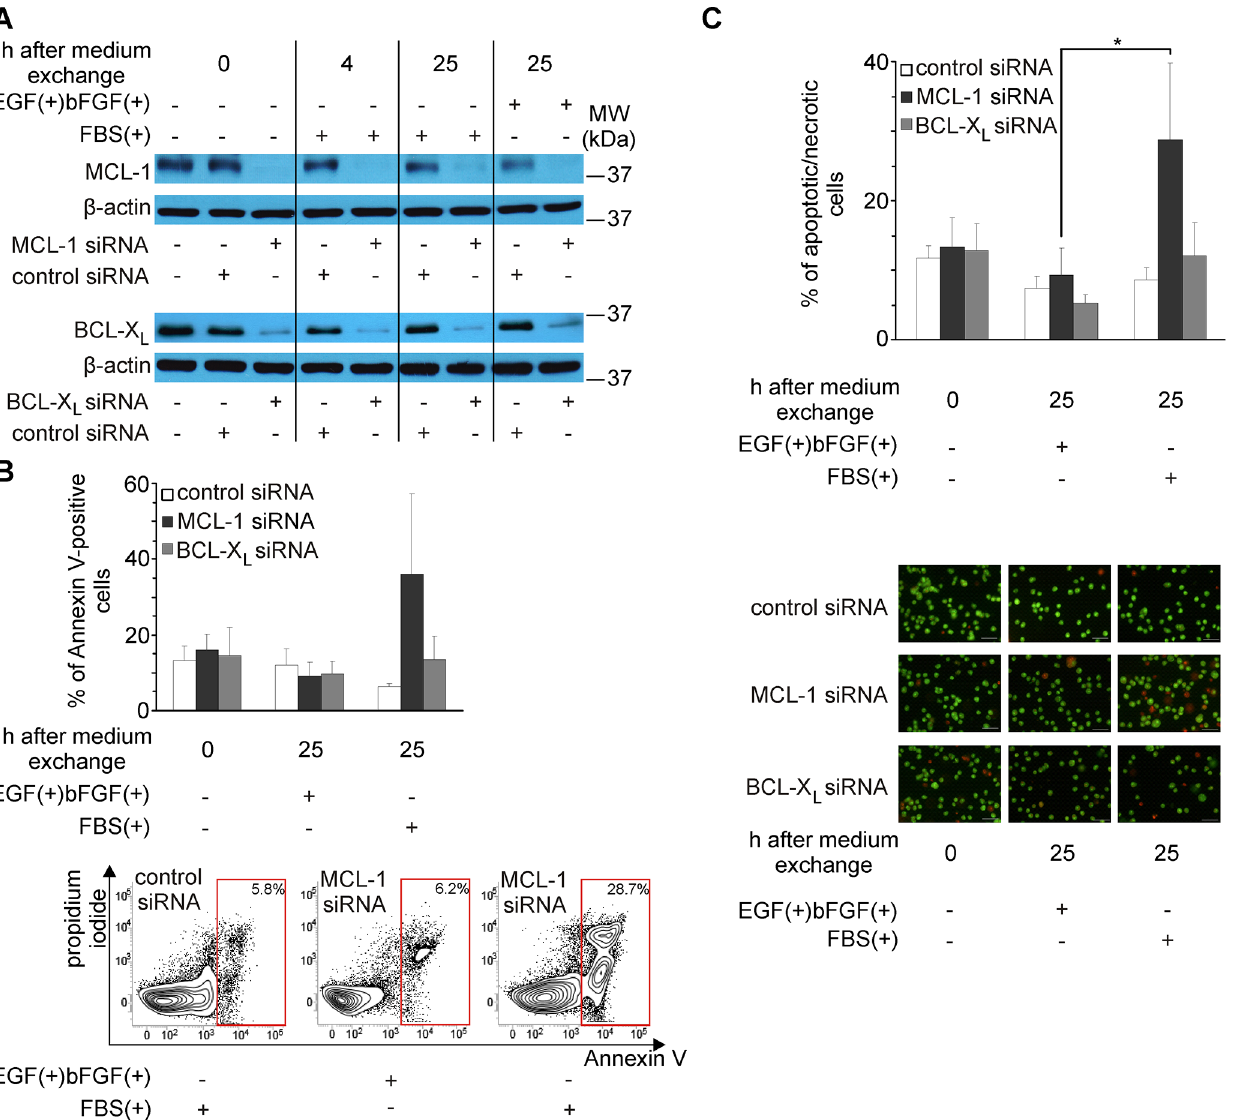
Fig 4. MCL-1 is involved in melanoma cell survival during adaptation to serum-containing medium. DMBC12 cells with silenced expression of MCL-1 or BCL-X L (0h) were exposed to serum-containing medium (FBS(+)), or in parallel they were transferred to fresh EGF(+)bFGF(+) medium. (A) Cell lysates were prepared at indicated time points and MCL-1 and BCL-X L proteins were immunoblotted (n = 3). Localization and molecular weight (MW) of marker bands are indicated. β -actin was used as a loading control. (B) Cells were stained with Annexin V/propidium iodide (PI) before (0h) and 25 h after medium exchange, and analyzed by flow cytometry. The percentage of Annexin V-positive cells is shown. Representative counter plots for melanoma cells after transfection with either control or MCL-1 siRNA are shown. They were acquired 25 h after transfected cell were transferred to either fresh EGF(+)bFGF(+) medium or serum-containing medium (FBS(+)). Data are presented as the means ± SD from three independent experiments. (C) Quantitative analysis of the frequency of melanoma cells stained with acridine orange/ethidium bromide before (0 h) and 25 h after medium exchange. The percentage of apoptotic/ necrotic cells is shown. Representative microphotographs are shown below. Data are presented as the means ± SD from three independent experiments. * p <